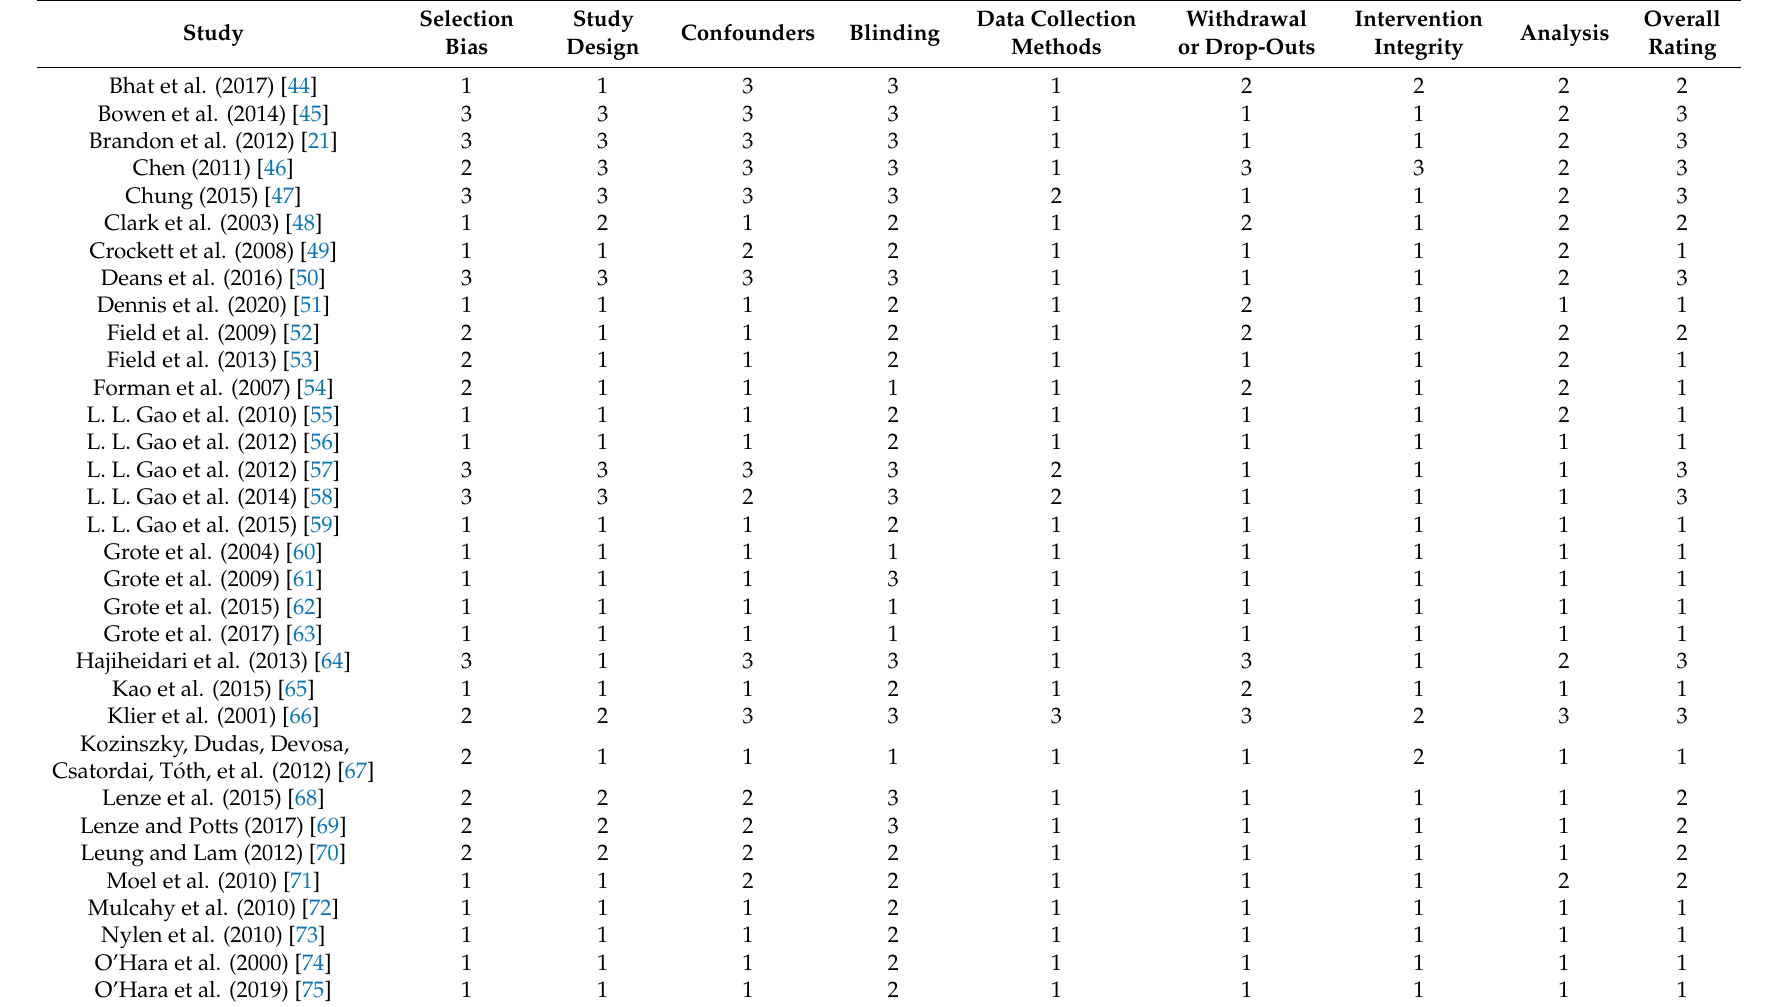
Table 4. E ff ective Public Health Practice Project (EPHPP) Quality Assessment